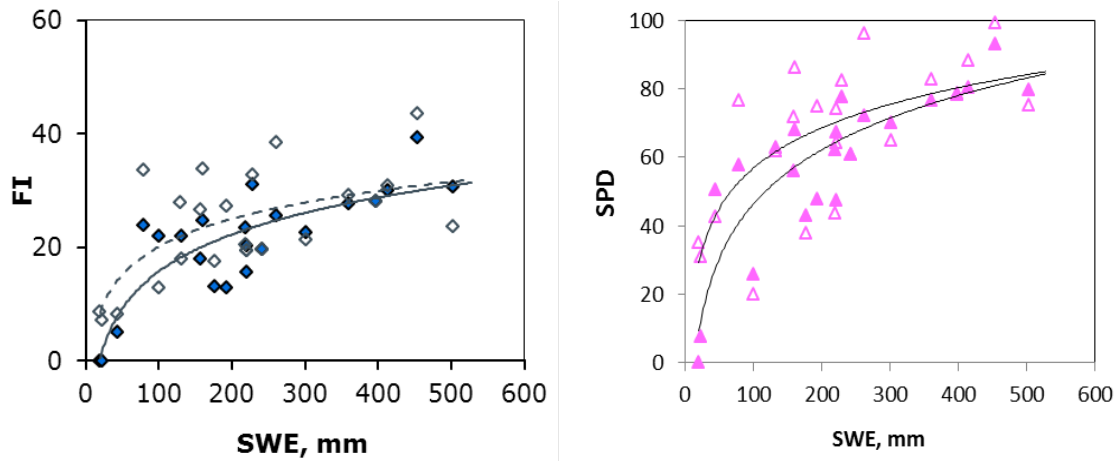
Figure 12. FI and SPD vs. SWE. The empty dots represent the model simulations carried out with the DMRT model, and the full dots the experimental data. Lines represent the regression equations for both simulated (dashed lines) and experimental (continuous lines) data.